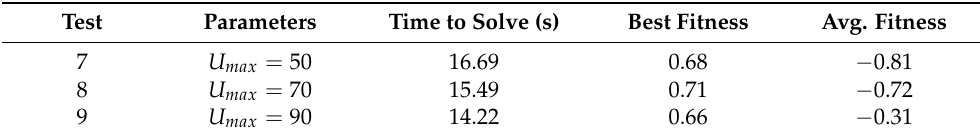
Table 4. Experiment 3. GP algorithm using objective function without penalties for suboptimal NUMA